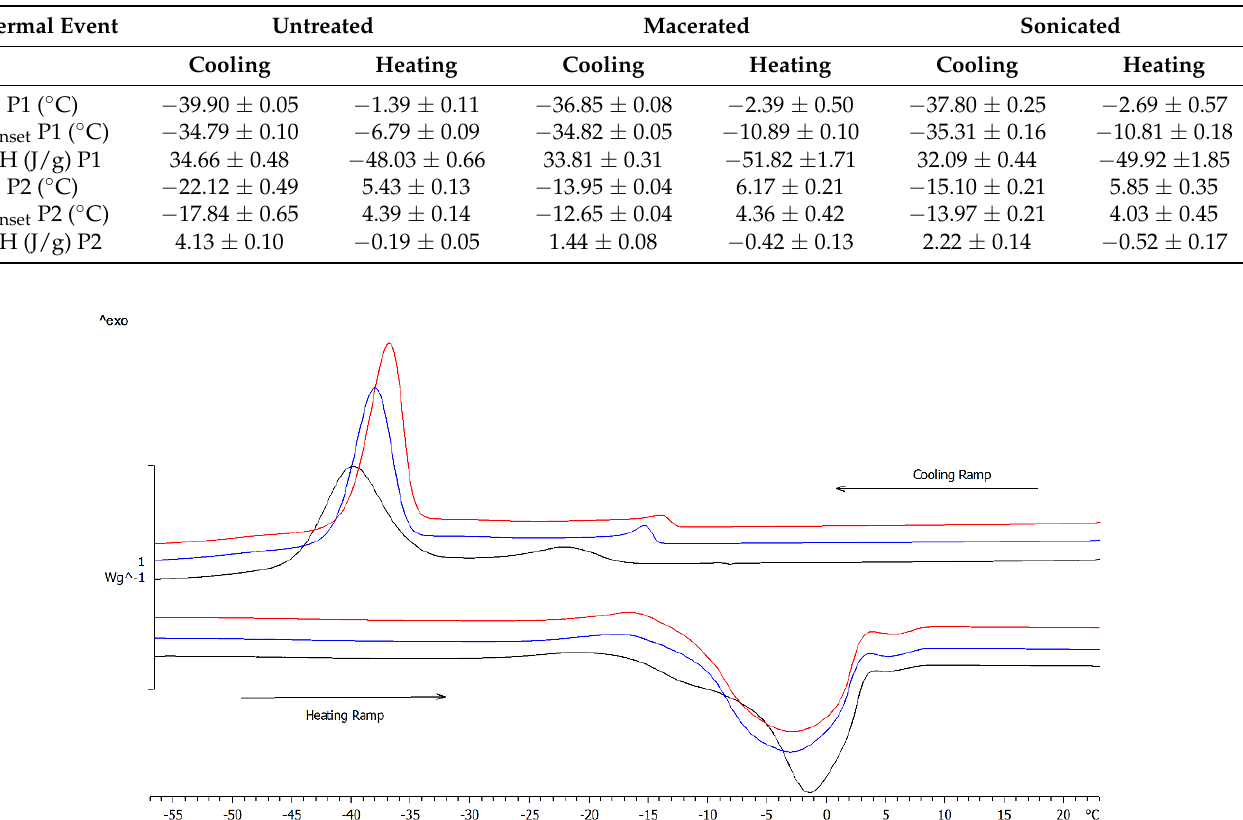
Table 8. DSC data on the thermograms of olive oil upon cooling and heating. The term “P1” and “P2” indicates the temperature corresponding to peak temperature of the major and the minimum exothermic event, respectively. “T onset ” is the onset temperature of the physical event (transition) and “ ∆ H” is the enthalpy.